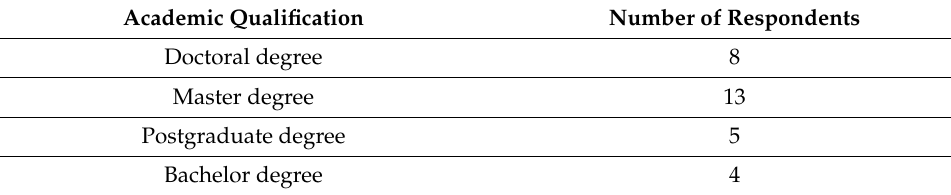
Table 2. Academic qualification.